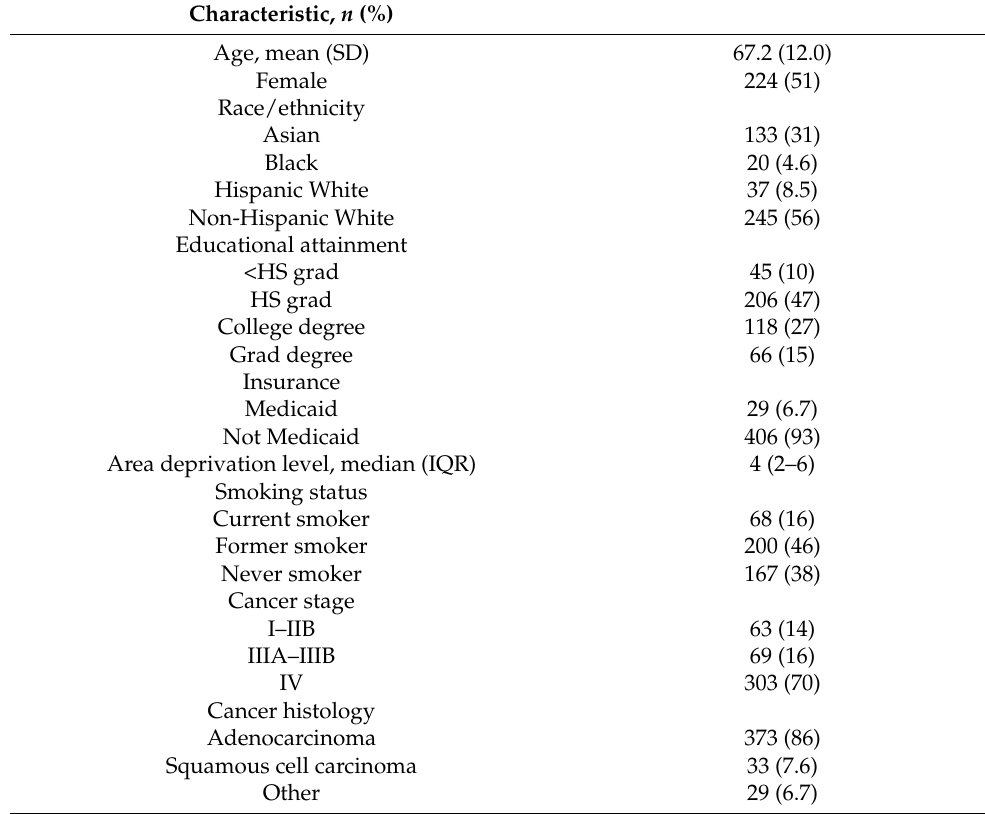
Table 1. Characteristics distribution of selected participants from the CCPS data ( n =